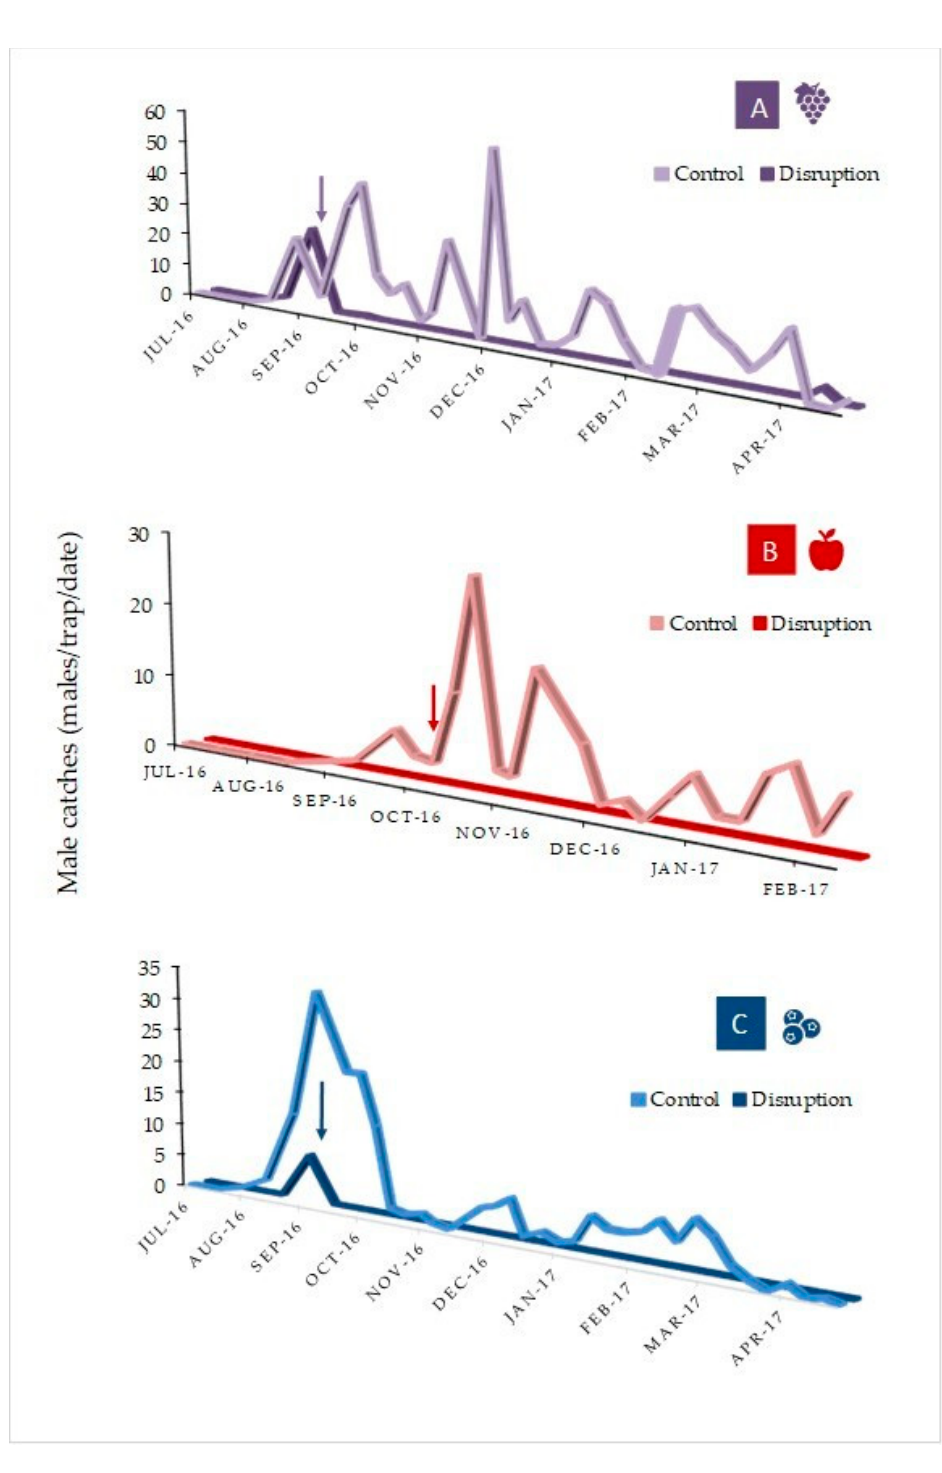
Figure 5. Proeulia auraria male captures (avg. males/2 traps*plot/date) in disruption plots (darker color line) and control plots (lighter color line) in a vineyard ( A : Requinoa), an apple orchard ( B : San Fernando), and a blueberry orchard ( C : San Francisco de Mostazal), all located in the O ´ Higgins region, central Chile, July 2016 through April 2017. The arrow indicates the respective date of SPLAT application.